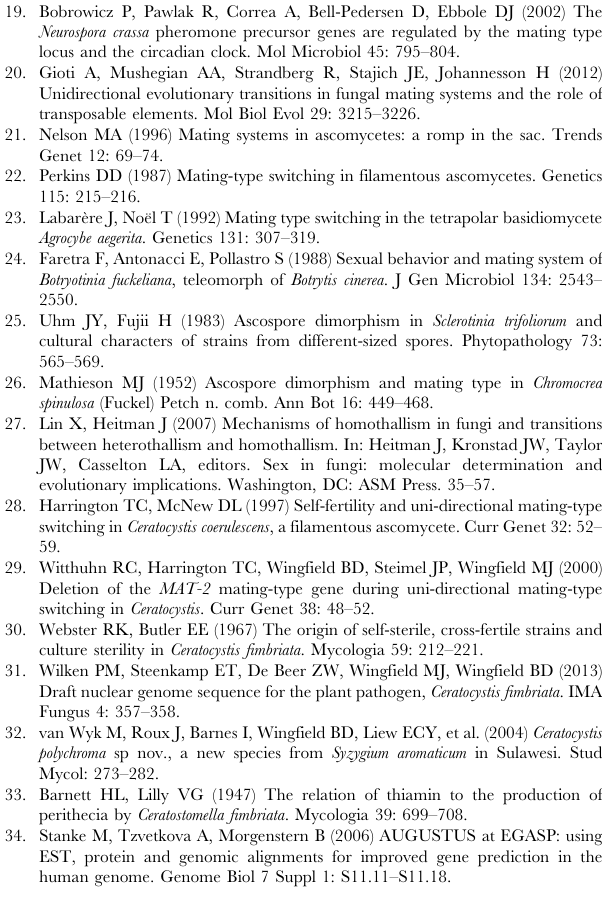
Table S1 Bi-directional BLAST analysis to identify MAT genes from the Ceratocystis fimbriata CMW14799 genome sequence.